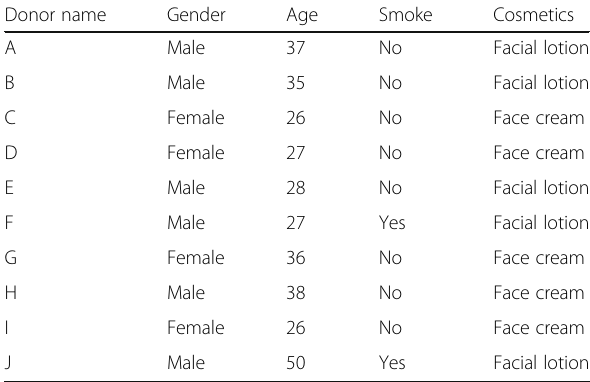
Table 1 Characteristics of the fingerprint donors